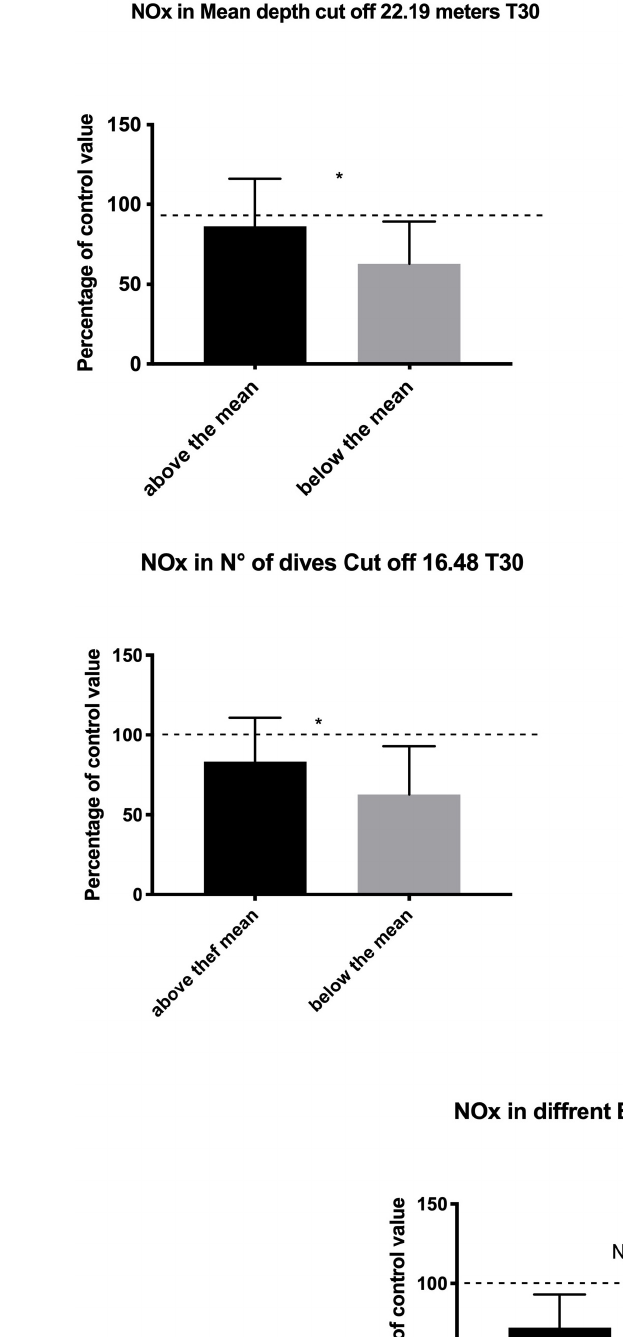
Frontiers in Physiology |